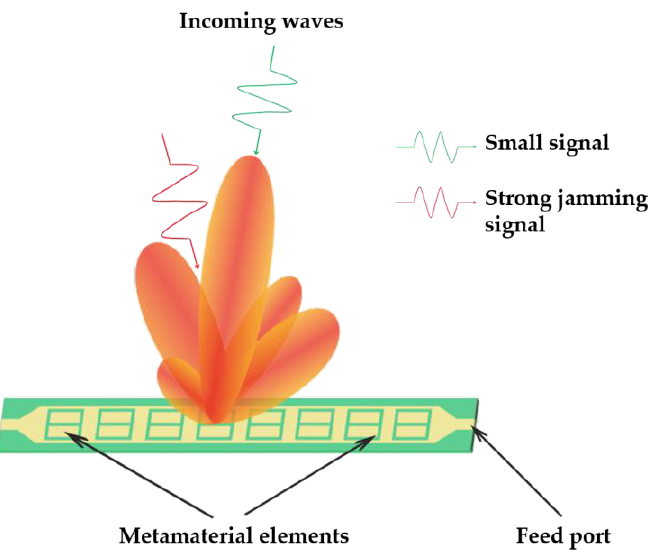
Figure 2. Small-signal anti-jamming model based on single DMA.